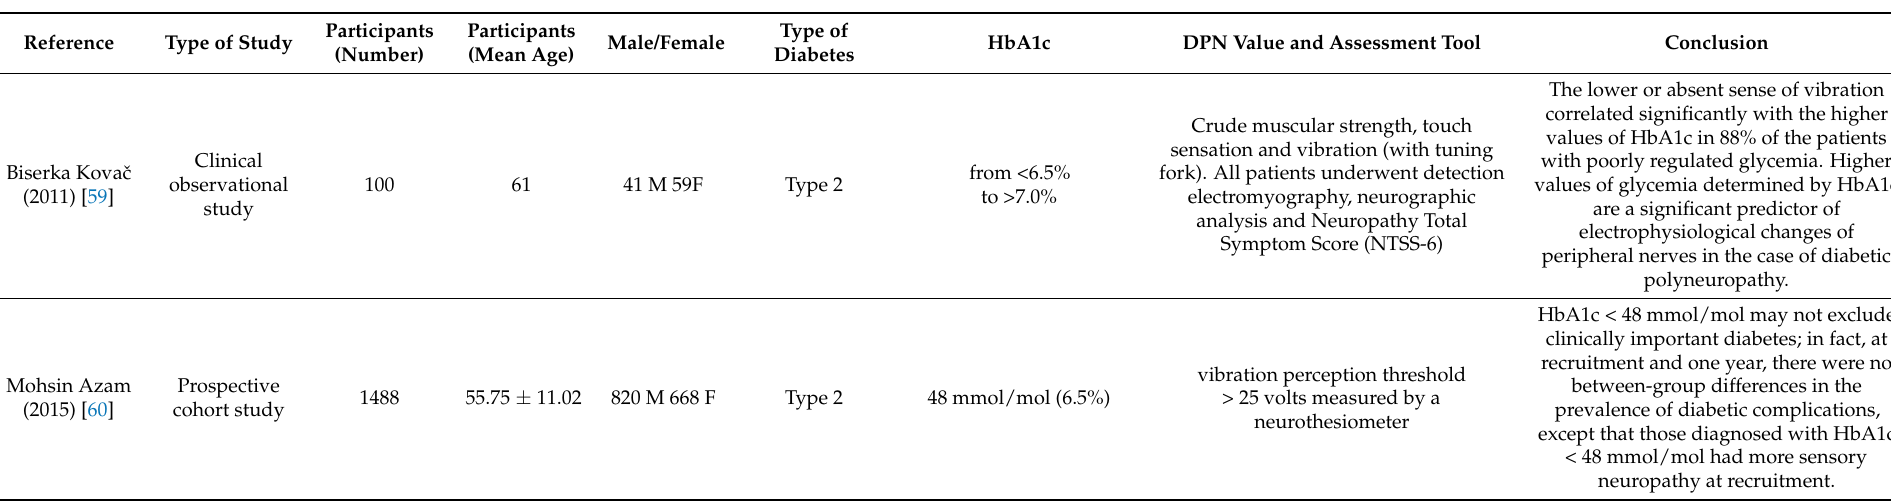
Table 2. Studies examining the usefulness of HbA1c as a biomarker for the early detection of